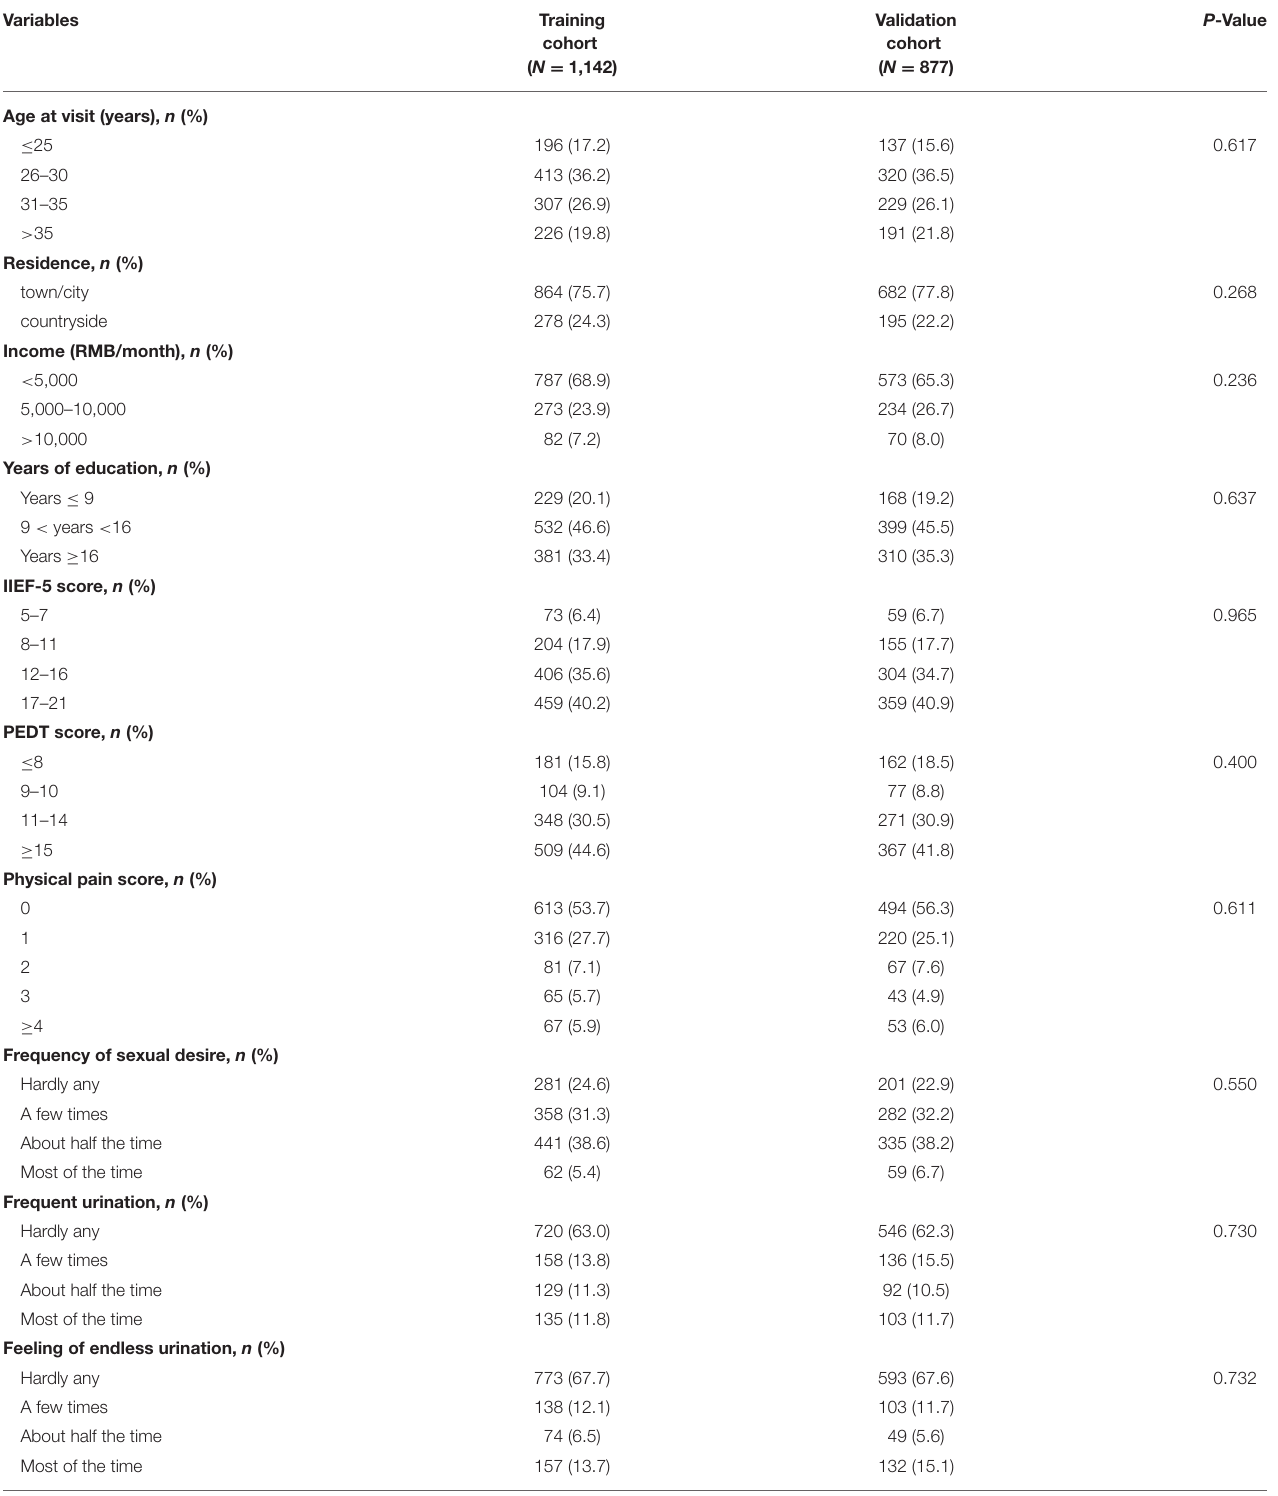
TABLE 1 | Comparison of variables between training cohort and validation